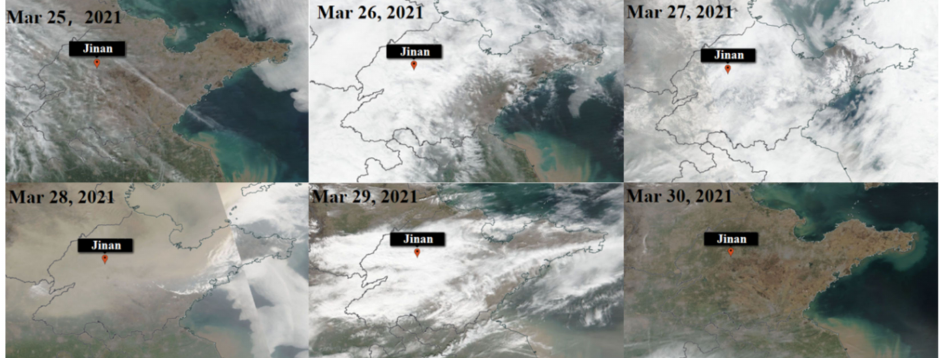
Figure 2. Visible Infrared Imaging Radiometer Suite (VIIRS) Suomi NPP 6 km true color images acquired during the pollution event investigated in this study.